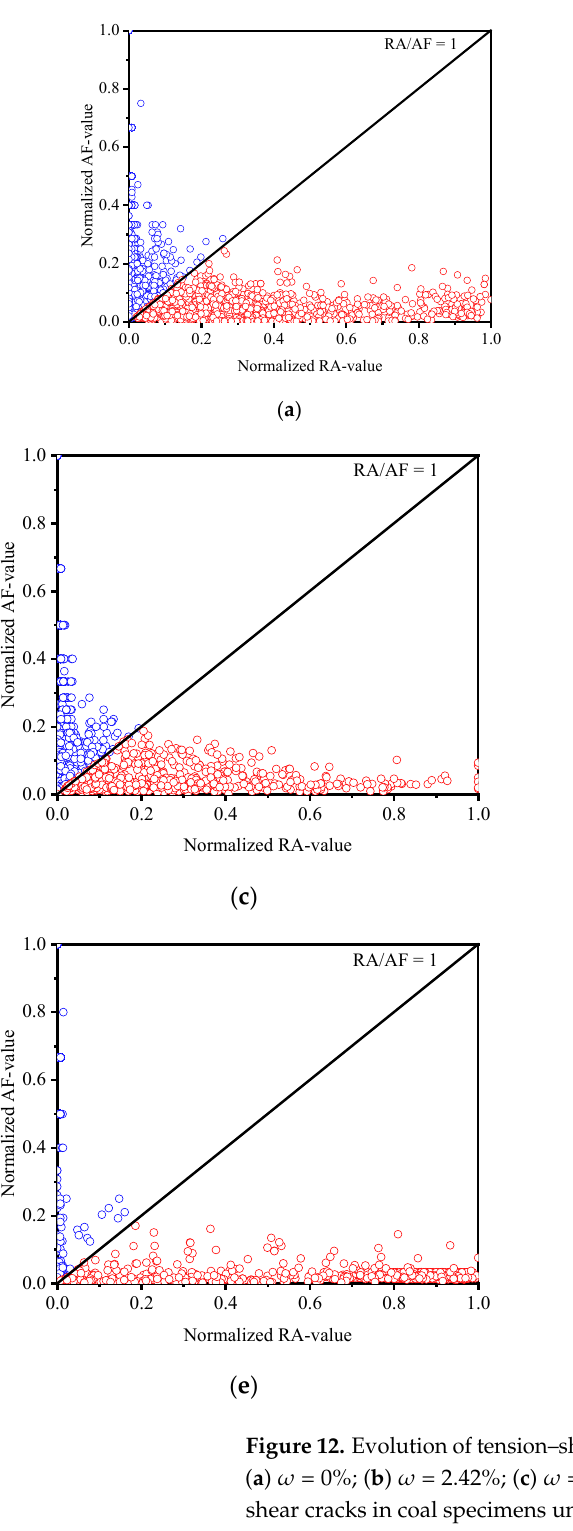
Based on the method described in Section 2.3, the AE parameters (ringing count and energy), cumulative AE parameters (ringing count and energy), CC threshold, CI thresh- old, and CD threshold of coal specimens under different inclination angles and moisture contents were obtained. In order to simplify the analysis process, the AE characteristics of coal specimens with a moisture content of 7.55% at different inclination angles were selected for analysis. Figure 13 shows the relationship between stress, AE parameters, cumulative AE parame- ters, and time at different inclination angles. Figure 14 shows the variation in the CC threshold, CI threshold, and CD threshold and their ratios ( σ CC / σ C , σ CI / σ C , σ CD / σ C ) with the inclination angle. Table 1 shows the specific values. The main conclusions are as follows.